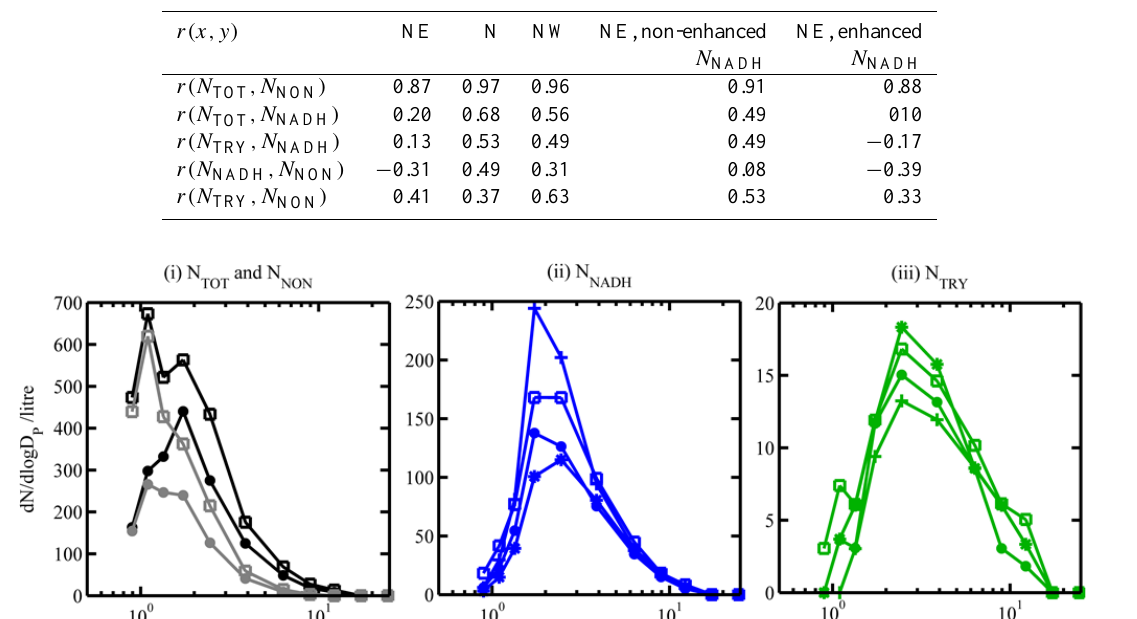
Table 2. Correlation coefficients ( r ) between WIBS-3 number concentrations, broken down by (i) modelled air mass origin and (ii) times of non-enhanced and enhanced N NADH /N TOT from 22 to 29 June, which are taken to be 10:00 to 20:00LT and 23:00 to 06:00LT, respectively.